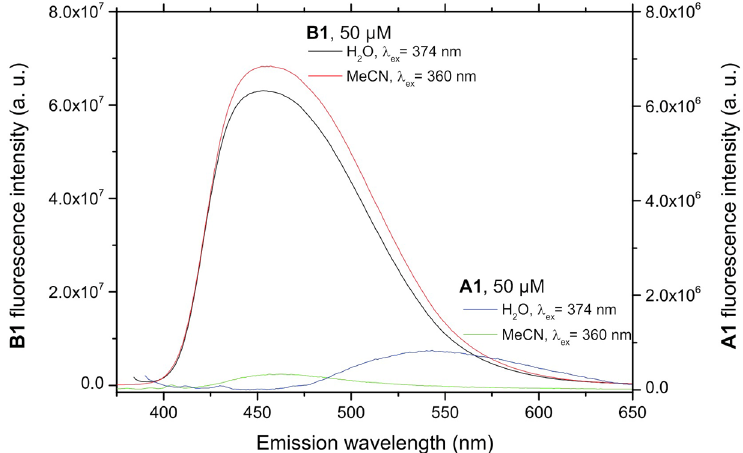
Figure 1. Comparison of the fluorescence spectra of compound A1 and its dehydrogenation derivative B1 . Note that the scale corresponding to the non-oxidized probe A1 is expanded ten-fold so that its emission spectra are visible.